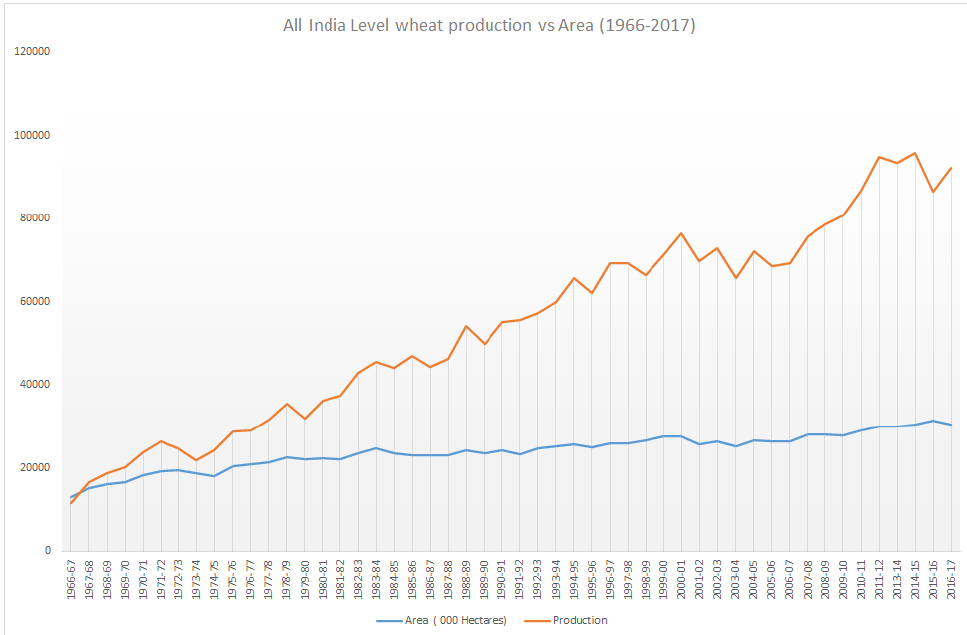
Figure 1: All India Level wheat production vs Area